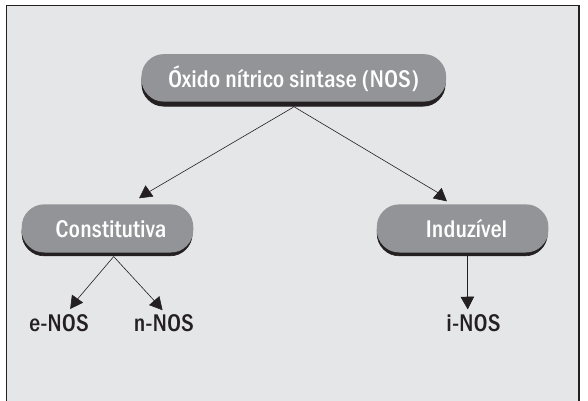
Figura 1 – Isoformas da NO-sintase